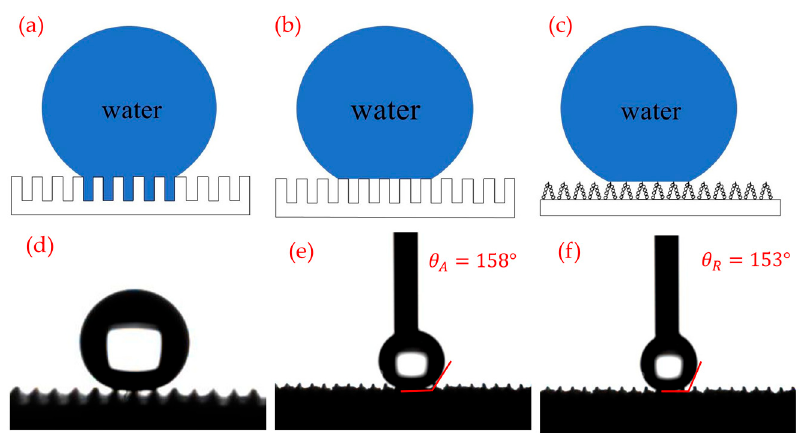
Figure 1. Wetting state: ( a ) Wenzel state; ( b ) Cassie-Baxter state; ( c ) Lotus state (a special case of the Cassie-Baxter state); ( d ) contact angle hysteresis (CA = 156 ◦ ) of water (2 µ L) droplet on the prepared superhydrophobic surface; ( e ) the advancing contact angle ( θ A = 158 ◦ ) of water (2 µ L) droplet on the prepared superhydrophobic surface is measured by increasing the droplet volume. ( f ) The receding contact angle ( θ R = 152 ◦ ) of water (2 µ L) droplet on the prepared superhydrophobic surface is measured by decreasing the droplet volume. The difference between the advancing and receding contact angles is particularly small, and the contact angle hysteresis ( θ A − θ R ) is always less than 10 ◦ .